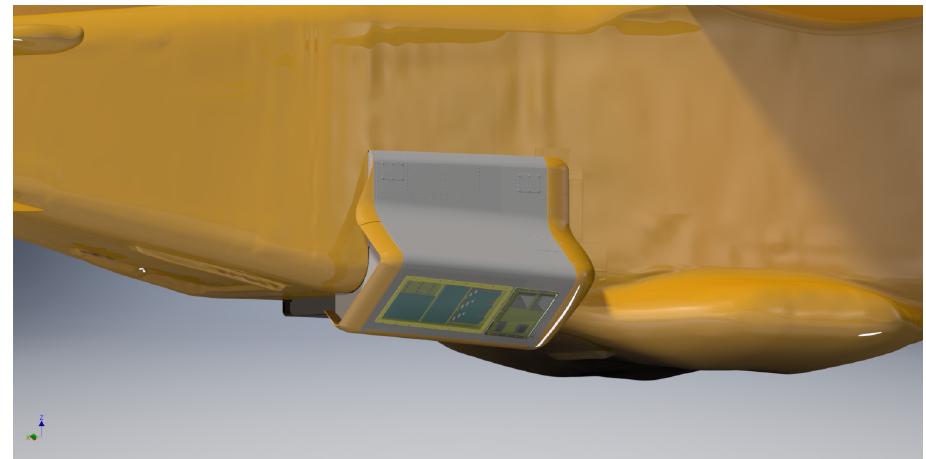
Figure 5. Schematic view of the DBFSAR antenna carrier mounted on the side of the aircraft